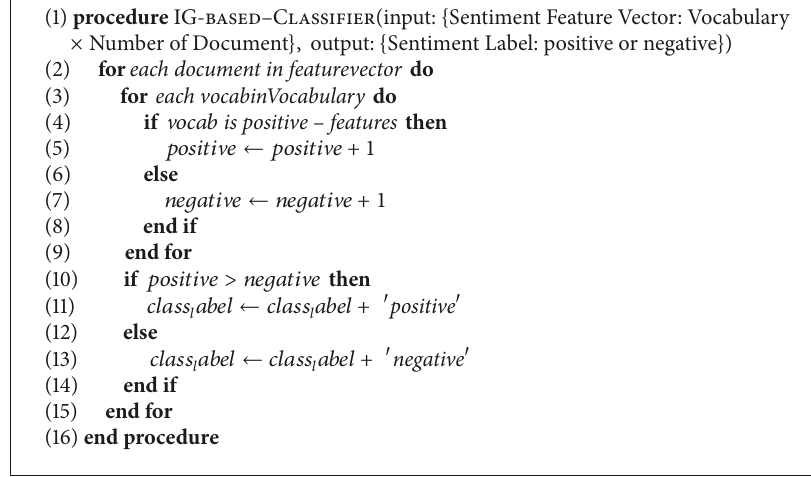
Algorithm 2: IG-based classification.